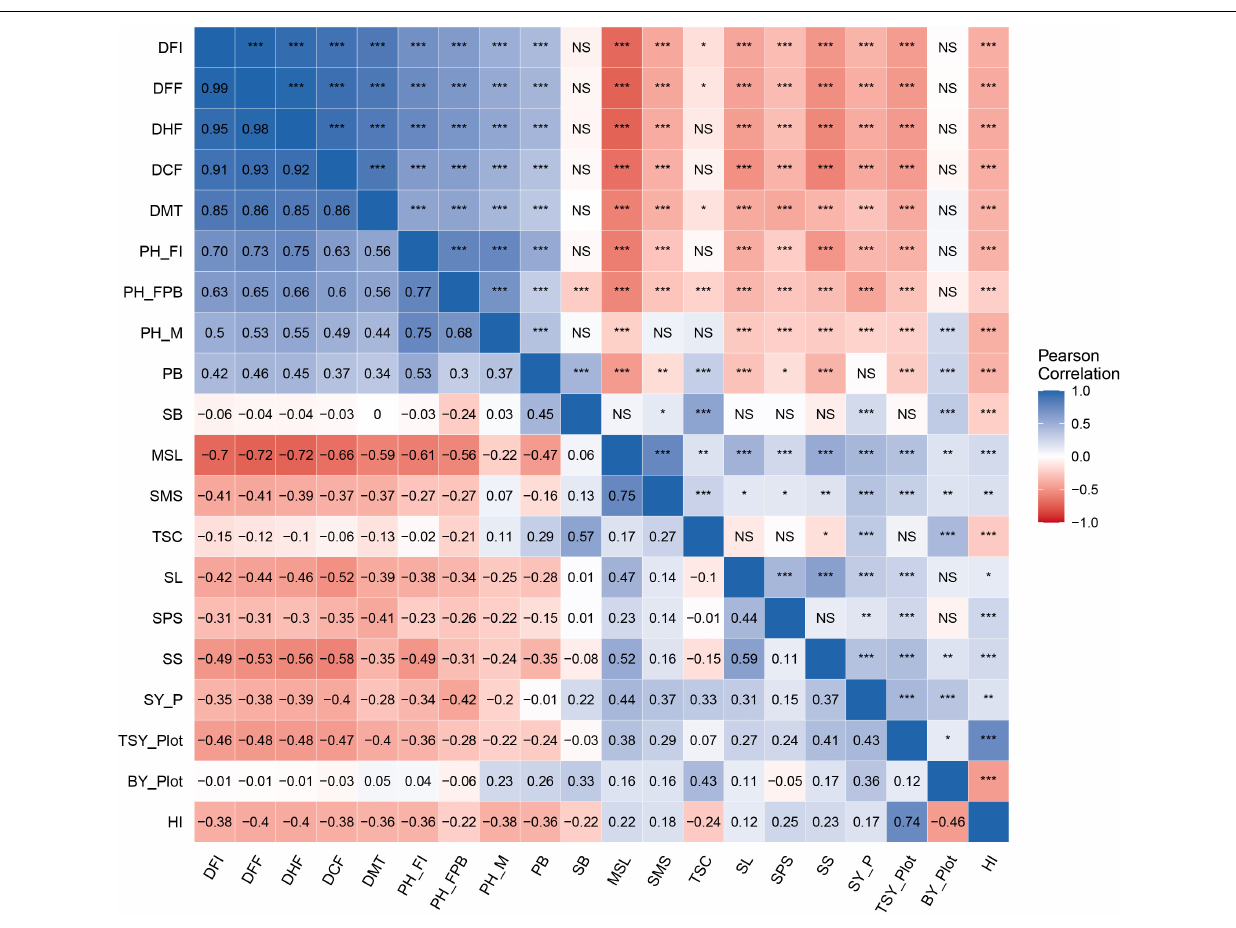
FIGURE 3 | Heat map of genotypic correlation matrix for yield and yield-contributing traits in Brassica juncea genotypes. Scale on the side of the figure indicates magnitude and direction of phenotypic correlations. Shades of blue from lighter to darker indicates strength of positive correlation between pairs of traits. Shades of red from lighter to darker indicates strength of negative correlation between pairs of traits. Lighter to white color indicates very weak or no correlation between pair of traits. Pearson’s correlation coefficients (lower diagonal) and significance (upper diagonal) among different traits measured in this study for genotypic BLUP values. Significance codes: *** p ≤ 0.001, ** p ≤ 0.01, * p ≤ 0.05, NS, not